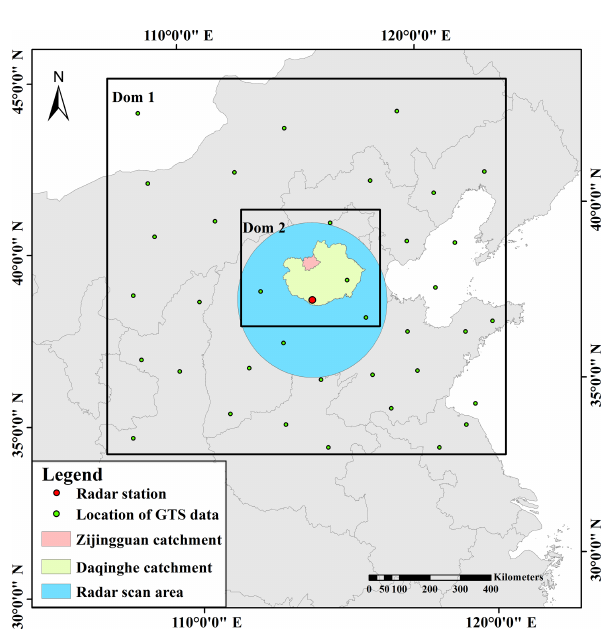
Figure 2. Locations of the radar scan area, the GTS data, the study catchments and the two nested